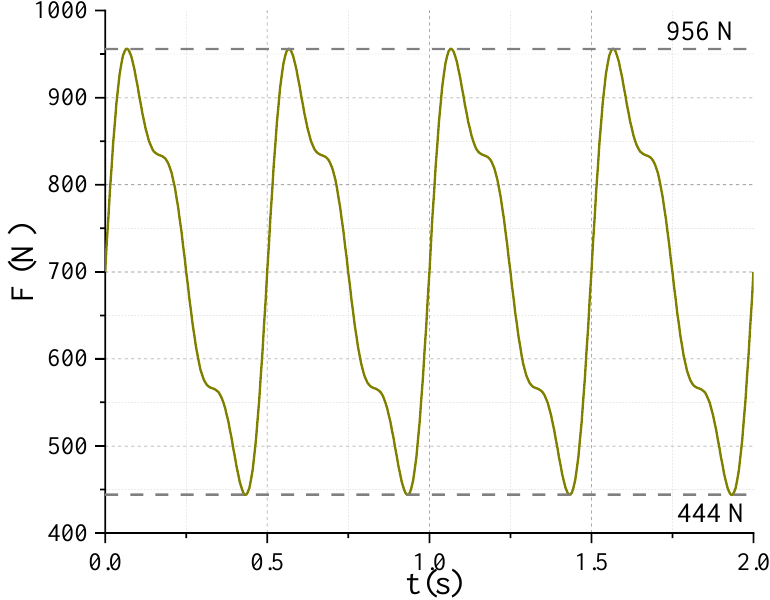
Figure 17. Time history of walking load.